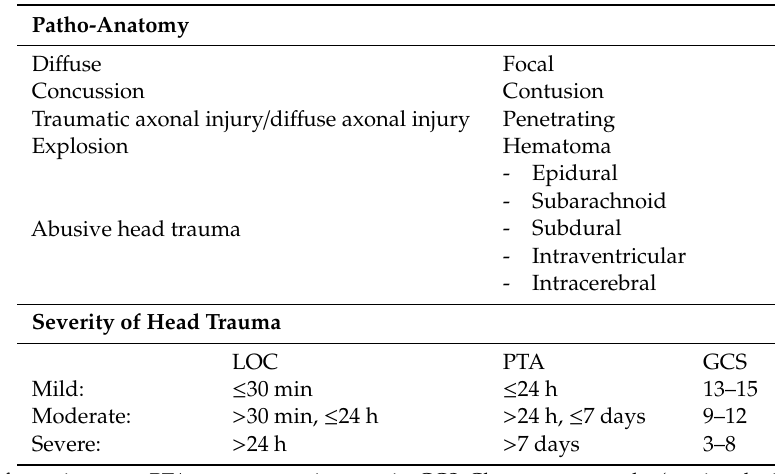
Table 1. Classification of traumatic brain injury